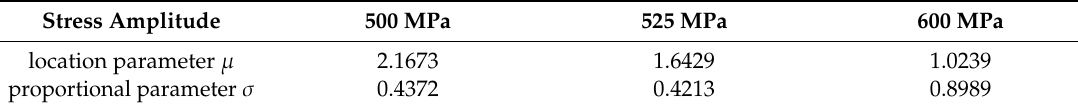
Table 3. The parameters µ and σ